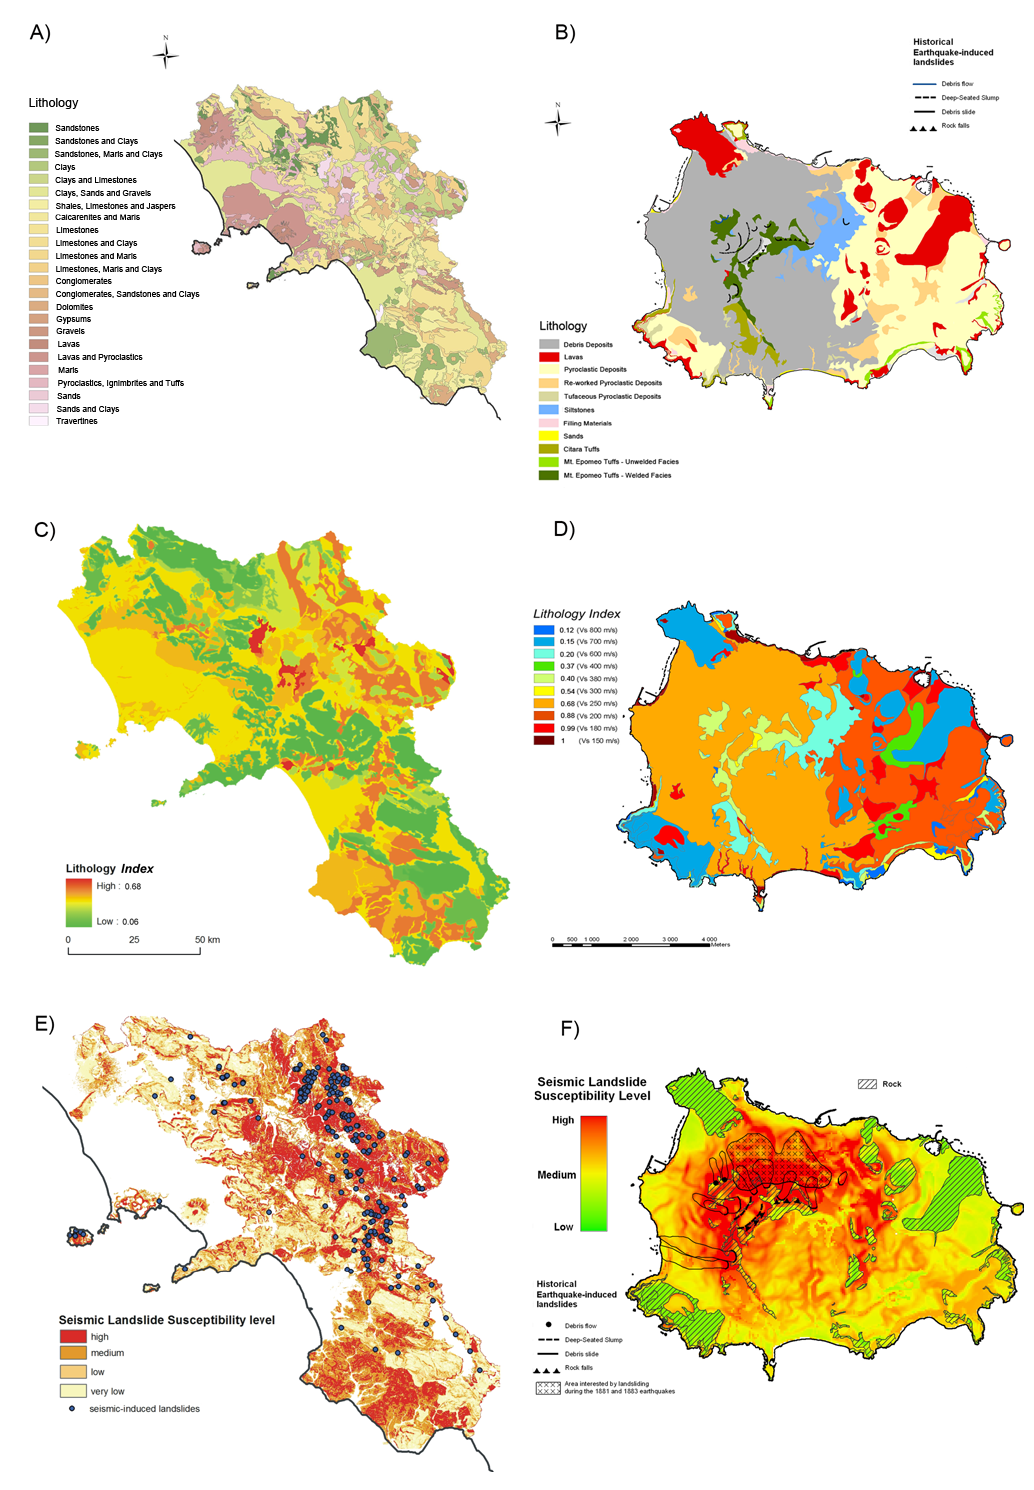
Fig. 7. Maps of the lithological units ( A and B ), lithology indexes ( C and D ) and susceptibility indexes ( E and F ) of two areas of southern Italy. Modified after Di Nocera and Matano (2011) and Rapolla et al. (2010,